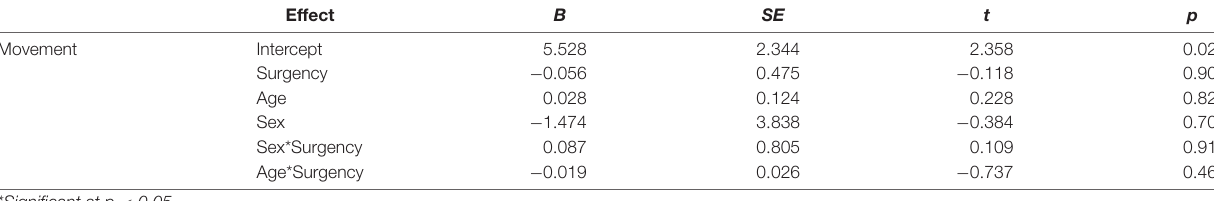
TABLE 4 | Regression results examining effects of Surgency, Age, and Sex and interactions between Sex*Surgency and Age*Surgency.